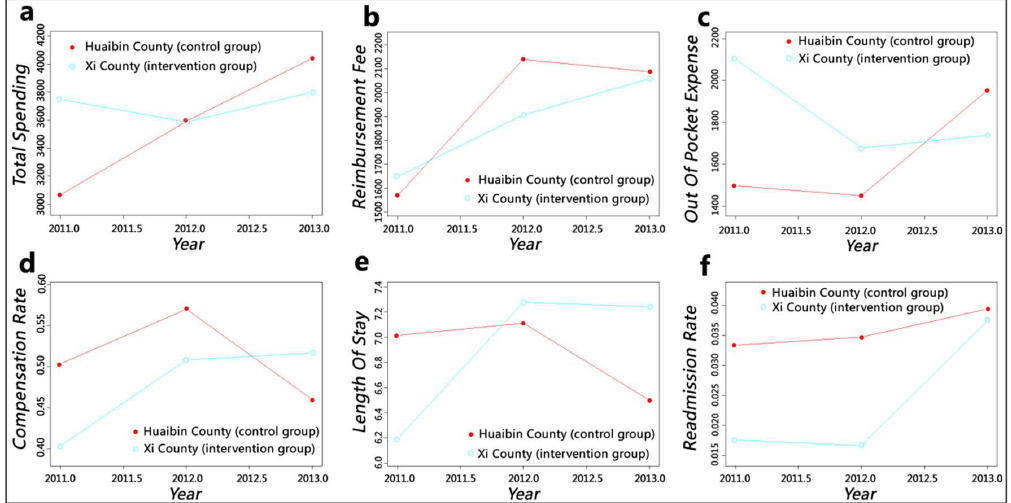
Figure 3. Smooth curves fitting for the county hospital level: ( a ) adjusted mean of total spending; ( b ) adjusted mean of reimbursement fee; ( c ) adjusted mean of out-of-pocket expense; ( d ) adjusted mean of compensation ratio; ( e ) adjusted mean of length of stay; ( f ) adjusted mean of readmission rate.